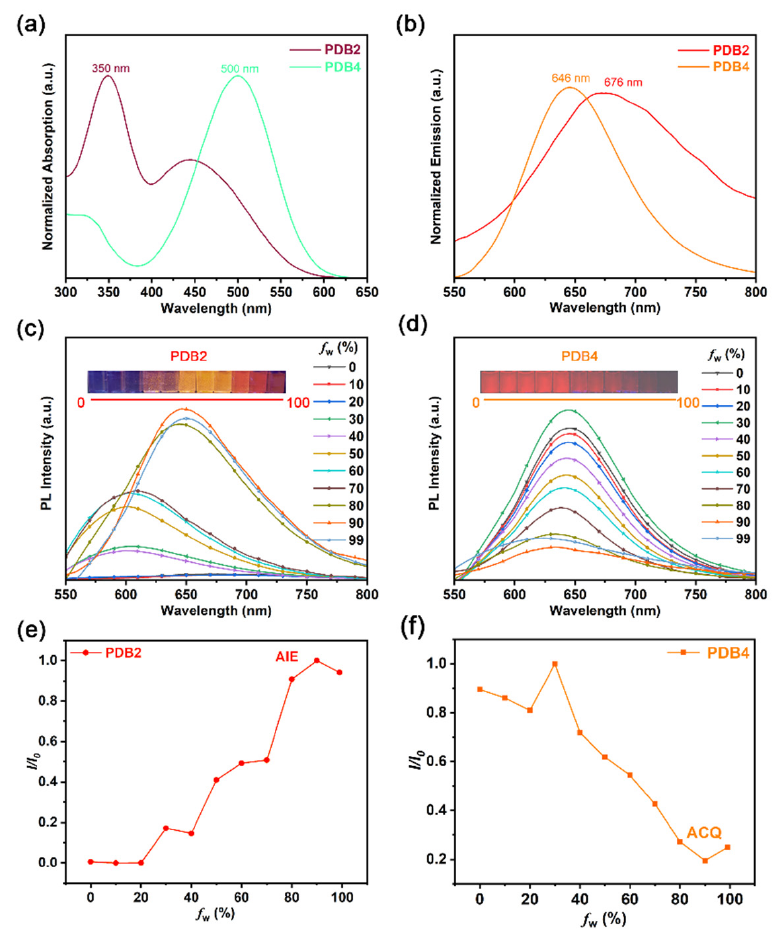
Figure 1. ( a ) UV/vis absorption spectra of PDB2 and PDB4 in DMSO solution (50 µ M). ( b ) PL spectra of PDB2 and PDB4 in DMSO solution (50 µ M). ( c , d ) Emission spectra of PDB2 and PDB4 in water − DMSO mixtures with different water fractions (50 µ M). ( e ) Emission intensity changes of PDB2 in different water − DMSO mixture ratios (I 0 : maximal PL intensity of f w to 90, I: maximal PL intensity of f w to other fraction points). ( f ) Emission intensity changes of PDB4 in different water − DMSO mixture ratios (I 0 : maximal PL intensity of f w to 30, I: maximal PL intensity of f w to other fraction